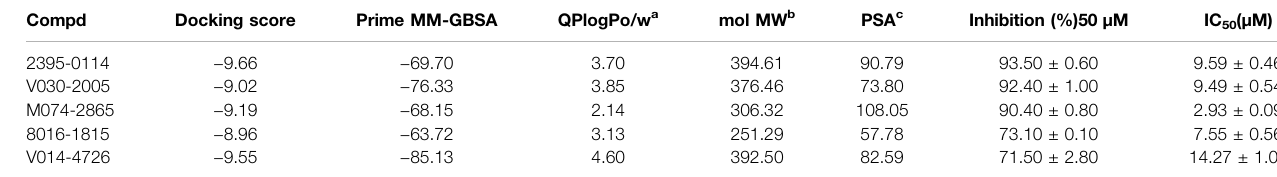
TABLE 1 | XP docking scores, MM-GBSA energy, physicochemical properties, and HPK1 inhibition activities of the screened compounds. Compd Docking score